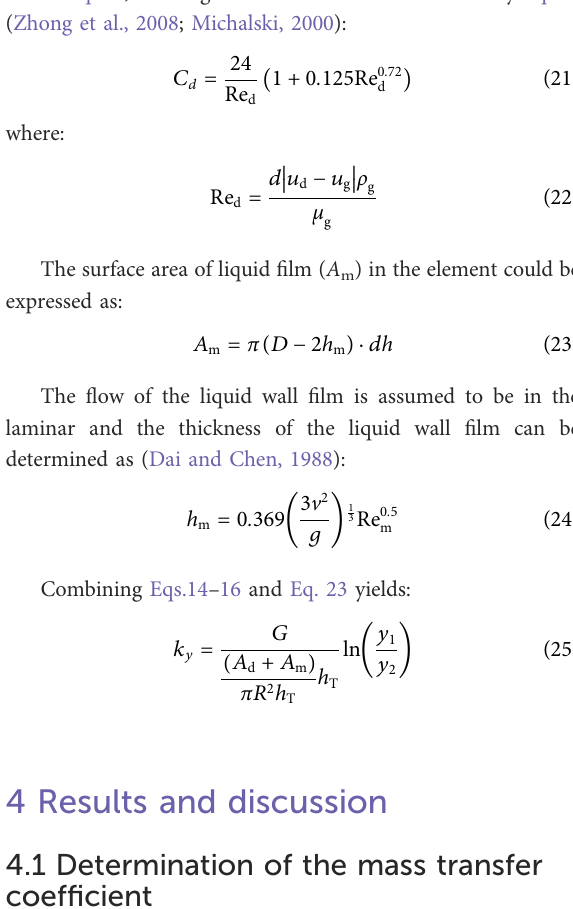
TABLE 1 Experimental mass transfer rate of SO 2